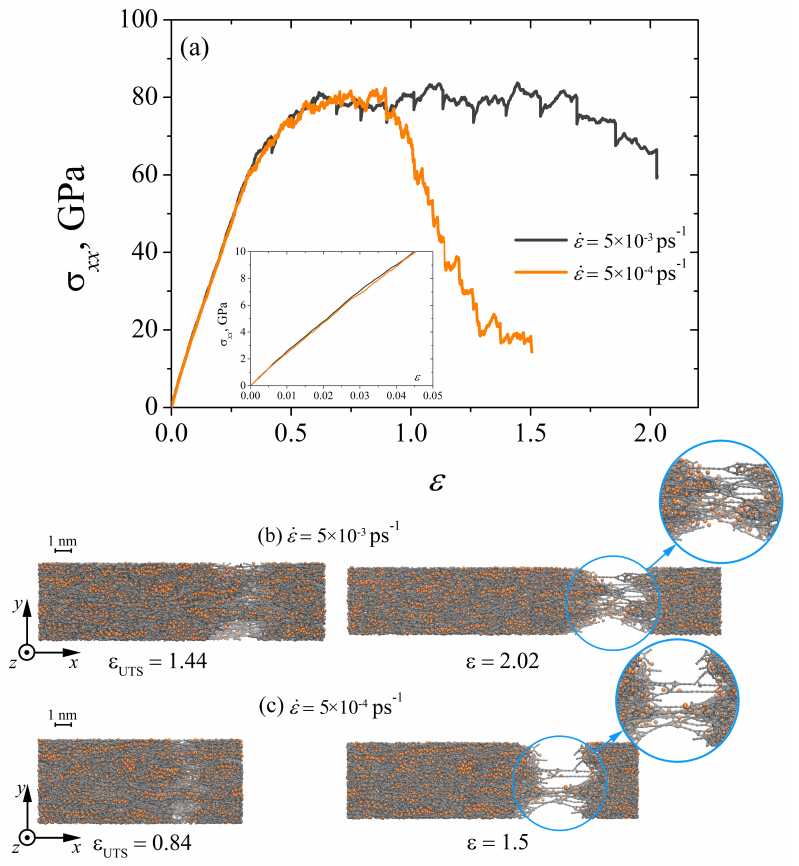
Figure 4. ( a ) Stress–strain curves during uniaxial incremental tension for Ni/graphene composite at different strain rates: ˙ ε = 5 × 10 − 3 ps − 1 and ˙ ε = 5 × 10 − 4 ps − 1 . ( b , c ) The snapshots of Ni/graphene composite at strain rates 5 × 10 − 3 ps − 1 and 5 × 10 − 4 ps − 1 , respectively. Colors as in Figure